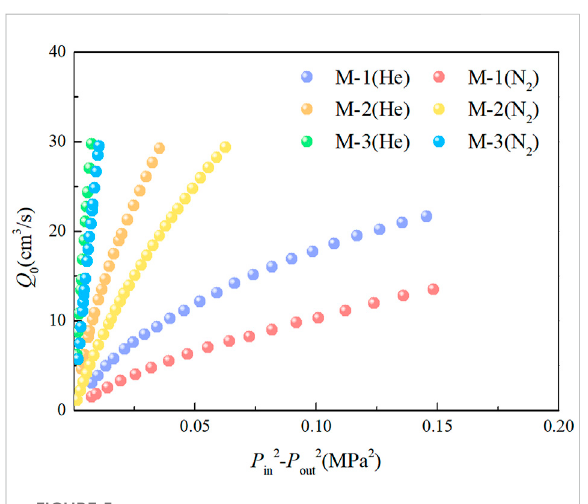
FIGURE 5 Relationship between the fl ow rate and square difference in the inlet and outlet pressures.